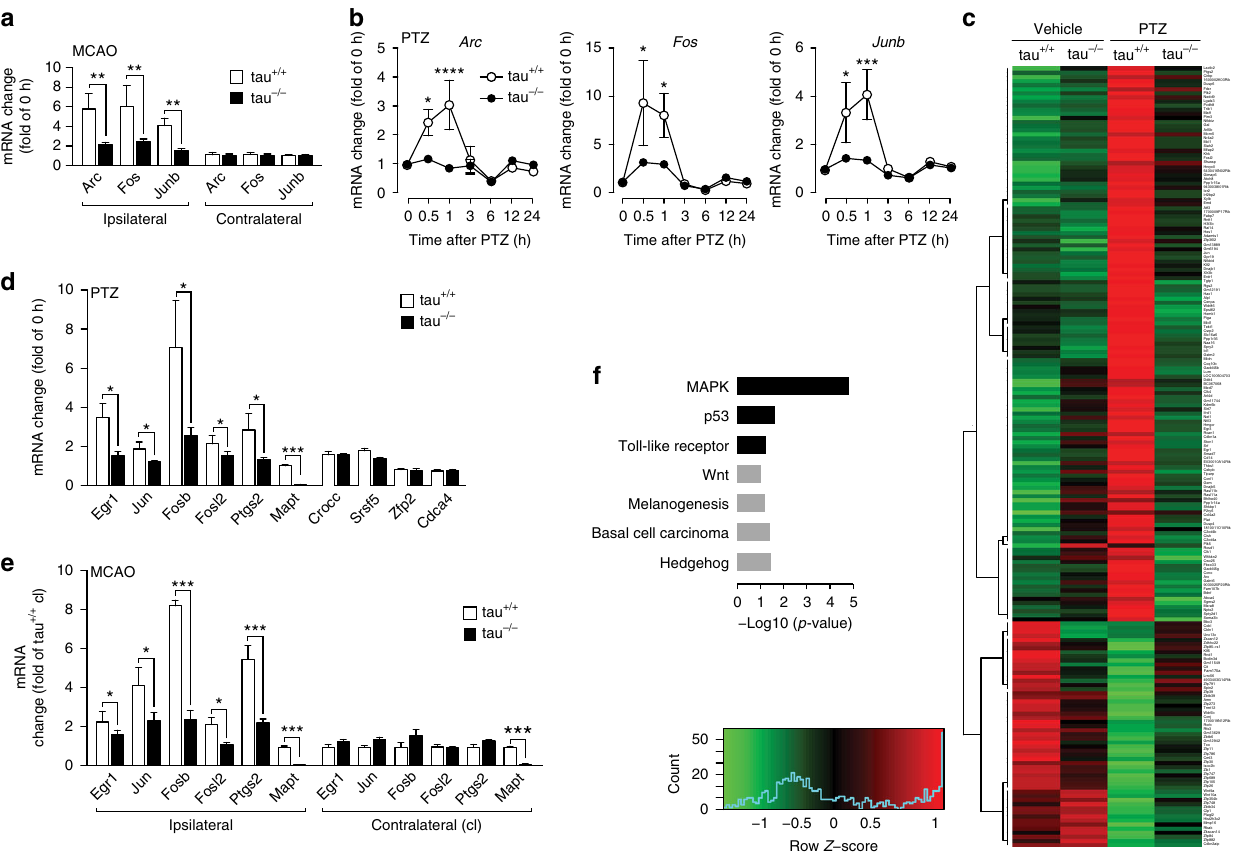
Fig. 4 Excitotoxic seizures and transient MCAO cause similar differential gene regulation in tau − / − mice. a Immediate early gene (IEG) activation for Arc, Fos and Junb in the affected hemisphere (ipsilateral) 1 h after transient MCAO in tau +/+ and tau − / − mice (** p < 0.01; N = 6; Student ’ s t -test). No gene induction occurred on the contralateral side. b Time course of IEG mRNA induction of Arc, Fos and Junb after PTZ administration in tau +/+ but little to none in tau − / − mice (* p < 0.05; *** p < 0.001; **** p < 0.0001; N = 6 per time point; two-way ANOVA (Holm-Sidak post hoc)). mRNA levels were determined by real-time PCR (rtPCR) using gene-speci fi c primers listed in Supplementary Table 3. c Whole transcriptome sequencing of tau − / − and tau +/+ mice treated with vehicle or PTZ revealed pronounced lack of gene induction/suppression 1 h after treatment in tau − / − mice. Red indicates up- and green down- regulation. Only genes with signi fi cant differential regulation are displayed. The displayed gene names are listed in order in Supplementary Data 1. d Quantitative rtPCR con fi rms differential regulation of selected transcripts from (see c ) tau − / − mice (* p < 0.05; *** p < 0.0001; N = 6; Student ’ s t -test), as well as similar regulation of others (selected from Supplementary Fig. 6 and Supplementary Data 2) in tau − / − and tau +/+ mice. e Quantitative rtPCR showed a similar pattern of differentially regulated genes in the ipsilateral hemisphere after transient MCAO compared to after PTZ (see d ) (* p < 0.05; *** p < 0.0001; N = 6; Student ’ s t -test), while there was no deregulation contralaterally in tau − / − and tau +/+ mice. f DAVID pathway analysis of genes that lacked response to PTZ administration in tau − / − mice (see c ) identi fi ed pathways that were up- ( black ) and down-regulated ( gray ) in tau +/+ mice. All error bars are